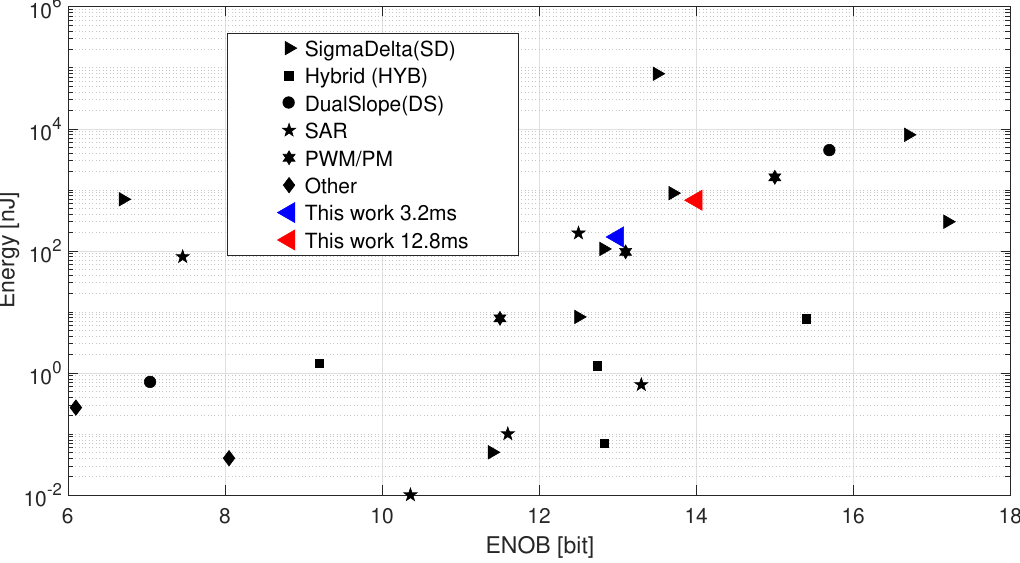
Figure 16. State of the art energy vs. resolution comparison. Table 3. Comparison with State-of-the-art CDCs peak FoM (Equation (21)).